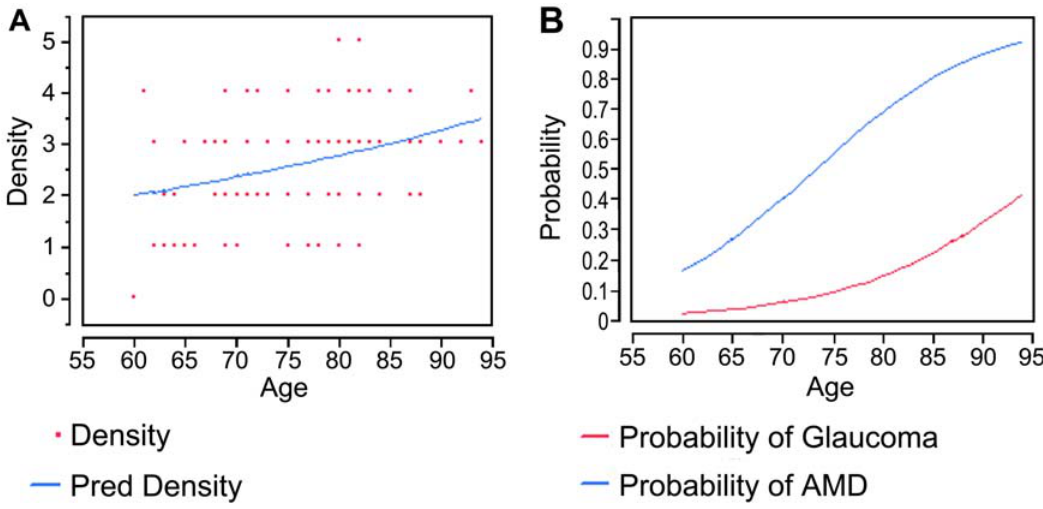
Figure 1. Scatter plot showing the density (number of distinct traits per patient) of the 10 complex ocular traits listed in Table 1 versus age for all 100 patients. A, The plotted points are the observed data and the line depicts the modeled relationship between age and density. B, The modeled probability of patients having AMD and glaucoma as a function of age using the logistic regression model.